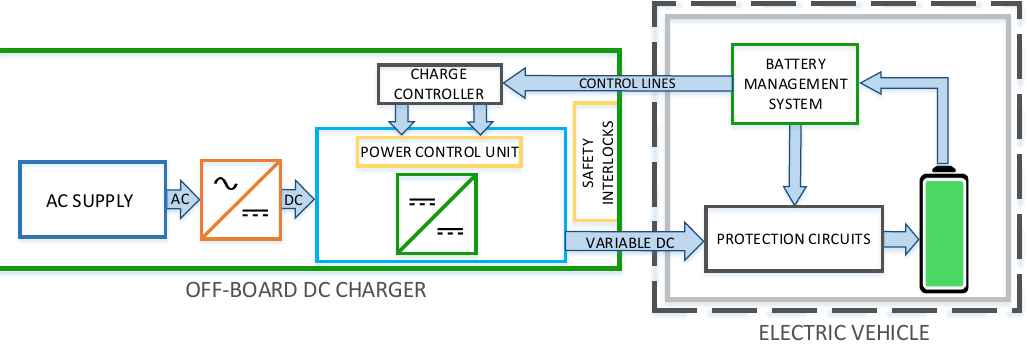
Figure 2. Conventional DC off-board charger